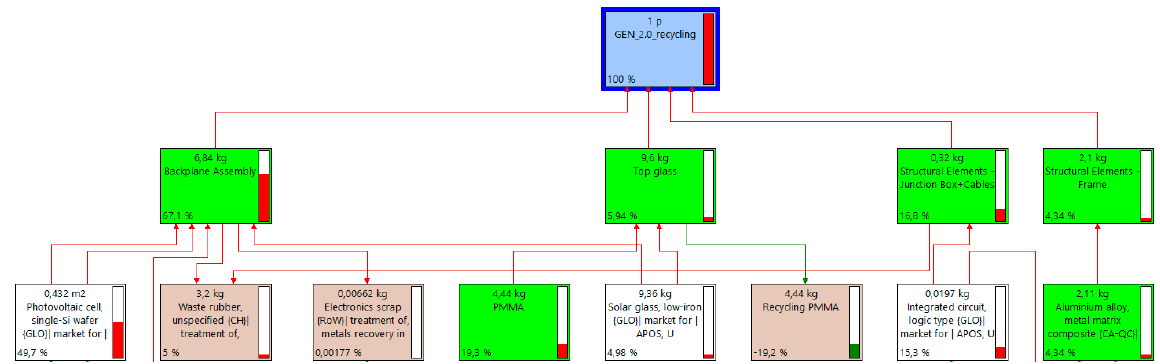
Figure 6. Reduced process tree showing the percentage of contribution of individual materials used to manufacture the module with recycling of PMMA, rubber, and electronic elements (only elements with a contribution higher than 3.5% are shown).